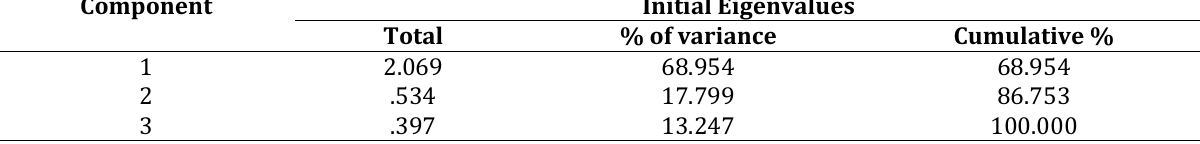
Table 13: Results of Eigen analysis of covariance matrix of the fuzzy logic variables Component